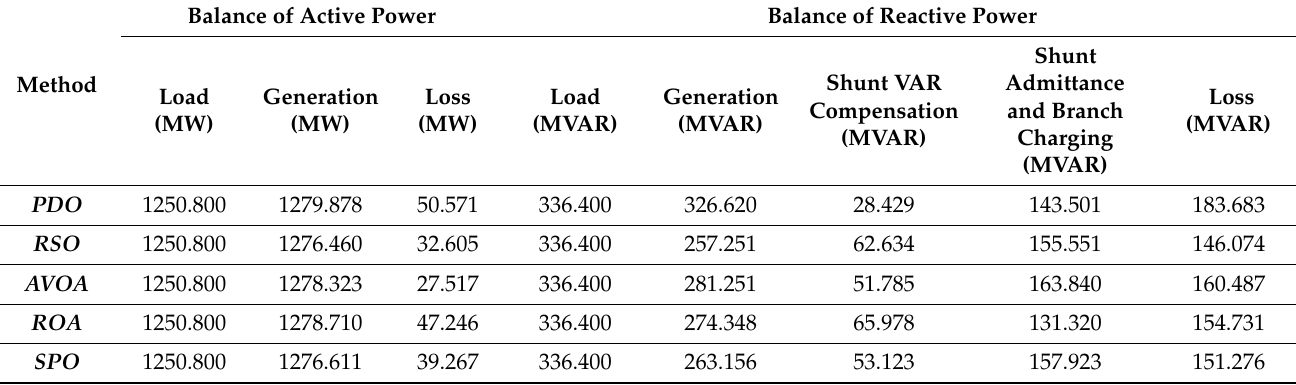
Table 21. Balance of active and reactive power for proposed algorithms with case 7.